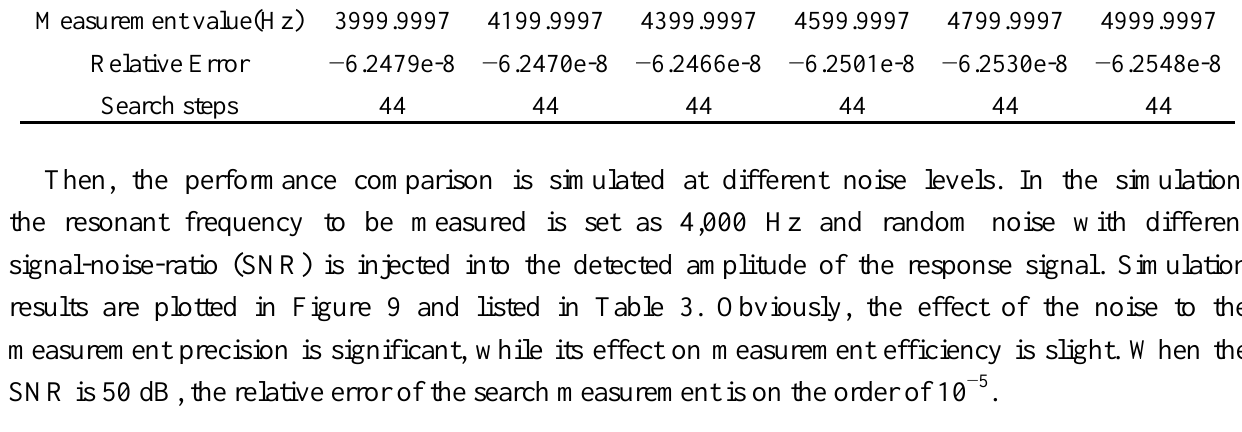
Figure 9. Measurement results of the search method under different level noise.